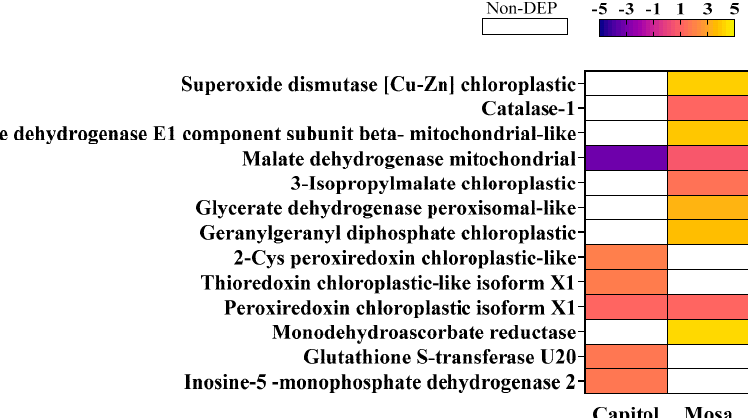
Figure 5. Reactive oxygen species (ROS) and redox-related differentially accumulated proteins in B. napus cultivars in response to Xanthomonas campestris pv. campestris ( Xcc ). Significantly expressed proteins (fold changes of ≥ 1.5 and ≤ 0.5 with p < 0.05, upregulated and downregulated, respectively) are presented as Log2 fold changes ( Xcc /Non- Xcc ). DEP—differentially expressed protein.